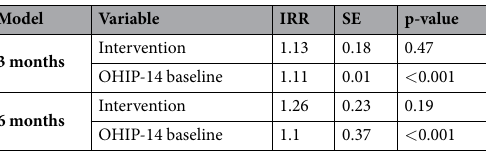
Table 2. Factors associated with OHIP-14 (negative binomial regression). 3-month final model: Omnibus Test: p < 0.001; Goodness of fit: deviance/df = 0.75; Pearson Chi-square/df = 0.66. 6-month final model: Omnibus Test: p = 0.003; Goodness of fit: deviance/df = 1.14; Pearson Chi-square/df = 0.73.